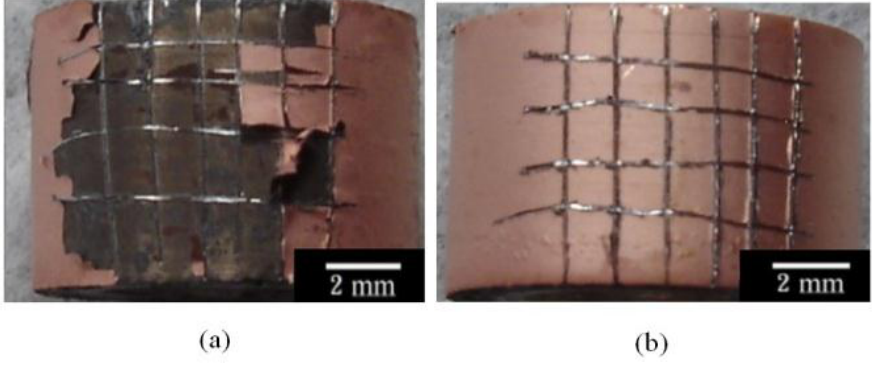
Figure 5. Surface morphology of the AZ80 RCE galvanostatically etched at the current density of 20 mA·cm −2 and Cu-electroplated at the current density of 40 mA·cm −2 at rotation speeds of ( a ) 500, and ( b ) 1000 rpm after the bonding strength